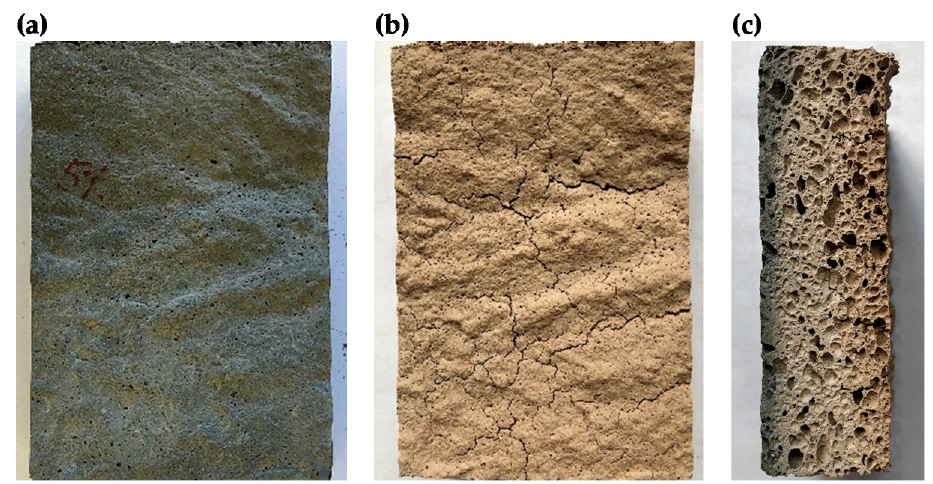
numerous surface cracks could be observed on the surface of the samples.